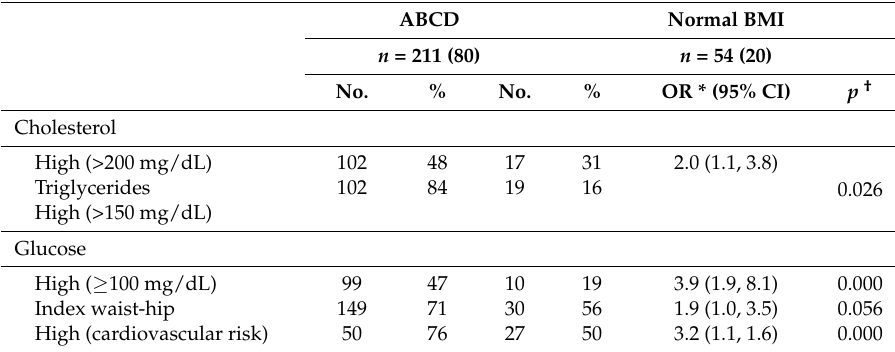
Table 2. Biochemical characteristics in ABCD vs. normal BMI.